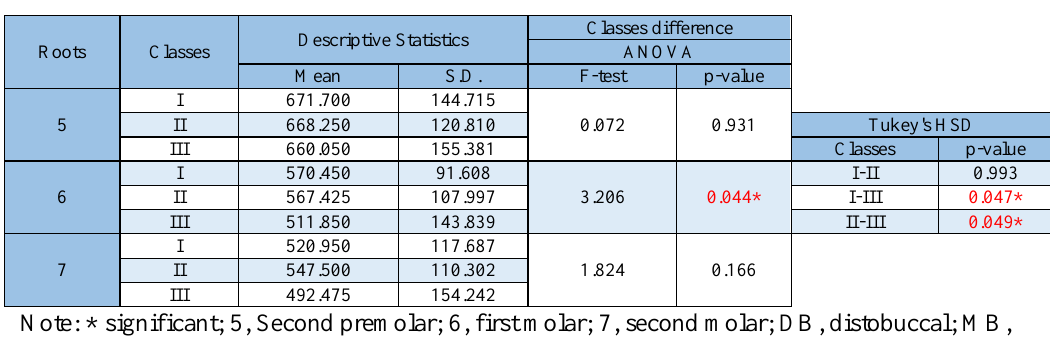
Table 3: Density of the sinus floor above root apices on CBCT according to classes